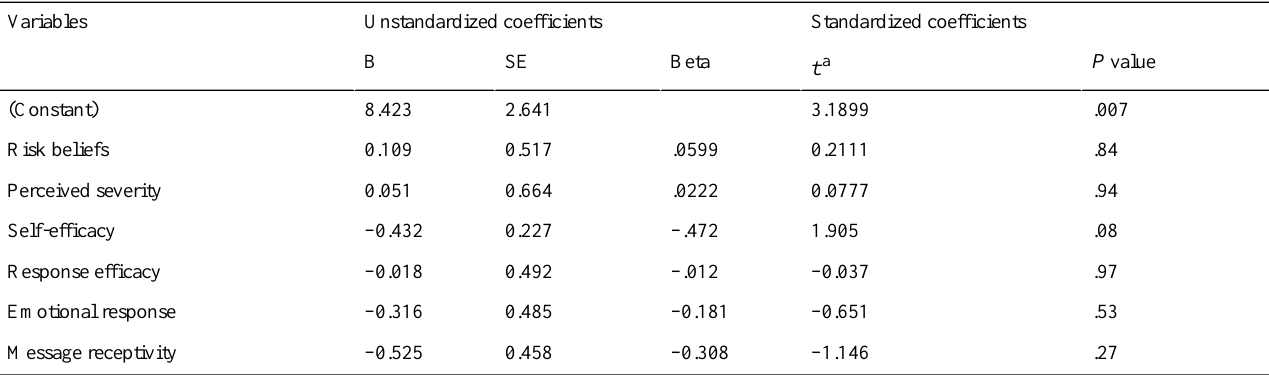
Table 5. Ordinary least squares linear regression with all variables included (no stepwise